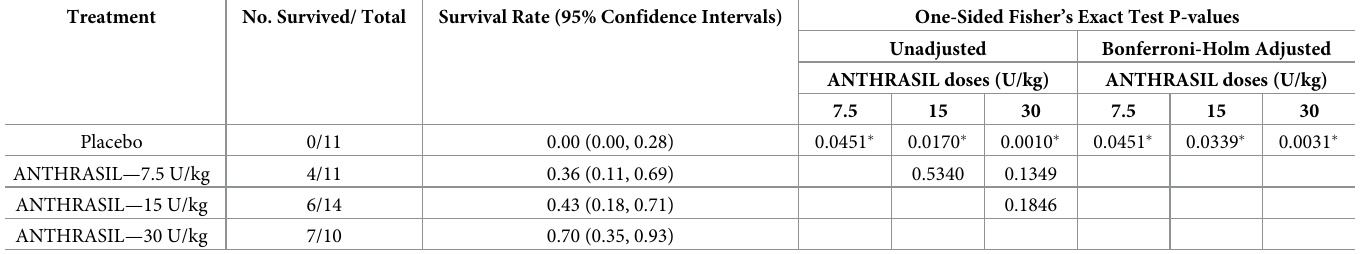
Table 7. Survival rates of B . anthracis -infected nonhuman primates treated with IGIV and ANTHRASIL (Modified intent-to-treat group).